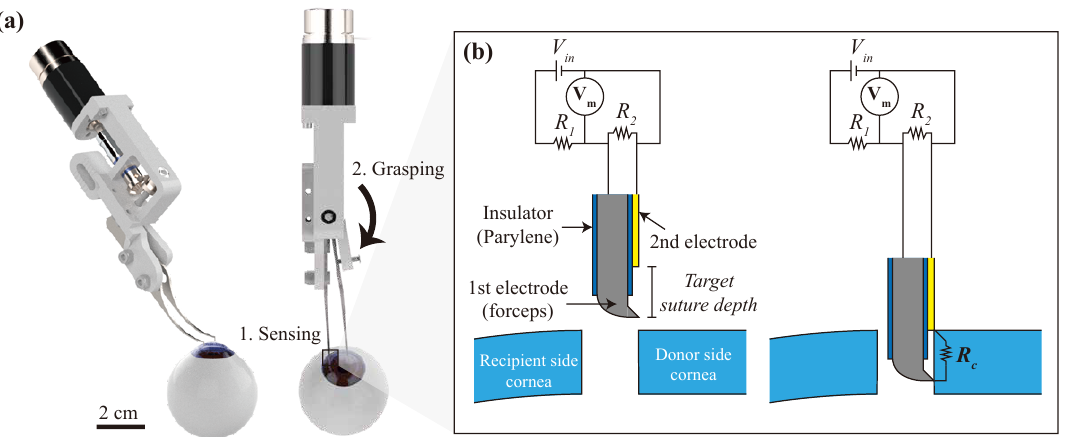
Figure 1. Mechanism of the proposed device. ( a ) When the device’s tip is inserted into the target suture depth, the sensor signal is activated, and the device rapidly grasps the cornea to prevent further position error induced by a human’s hand tremor. ( b ) The sensor part consists of two electrodes. When the device’s tip is inserted into the target suture depth, two electrodes are electrically connected through corneal